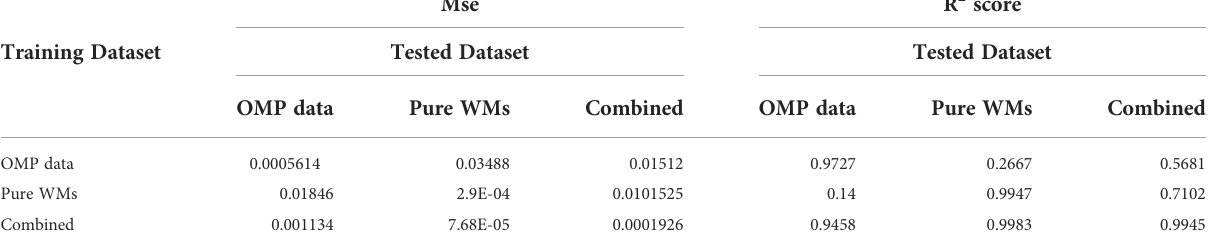
TABLE 6 Minimum square error (mse) and R 2 score of the Extremely Randomized Trees models when evaluated in the three testing sets including the SAIW water mass in the pure WMs